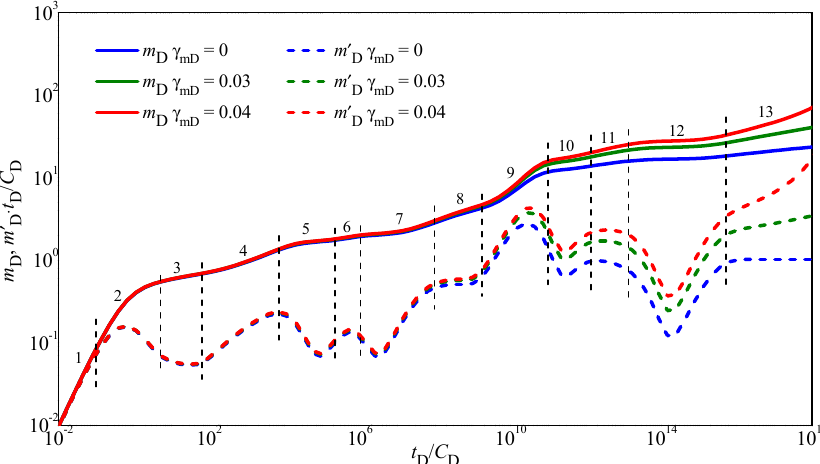
Figure 5. Influence of the permeability modulus on the pressure dynamic curve of the triple medium composite reservoir.